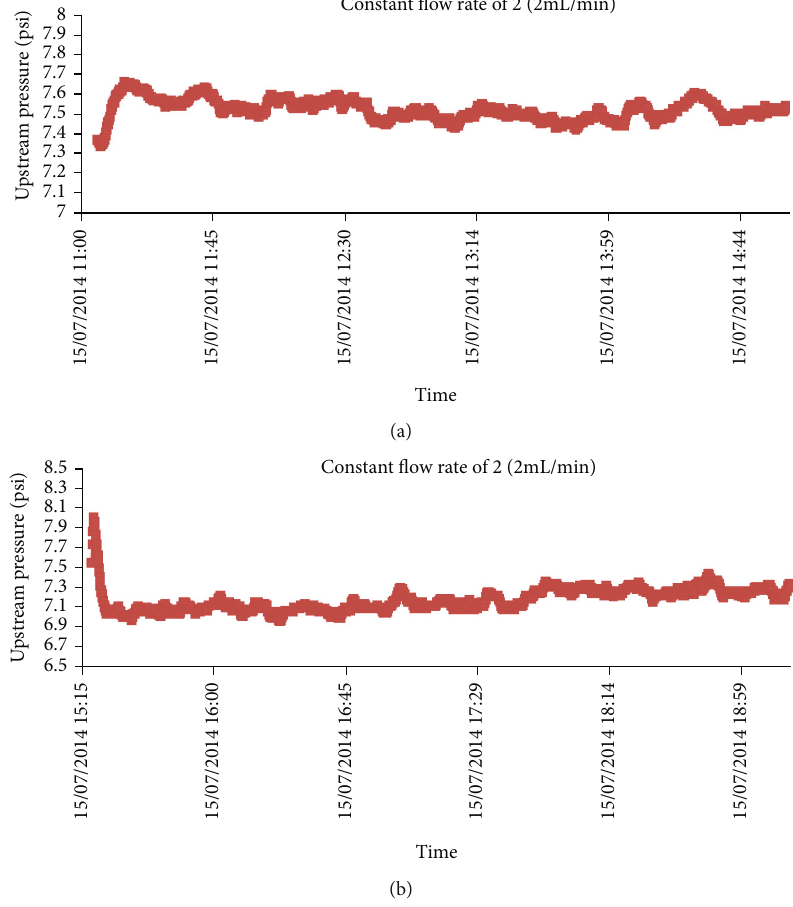
Figure 20: Upstream pressure curve from Roshan et al.